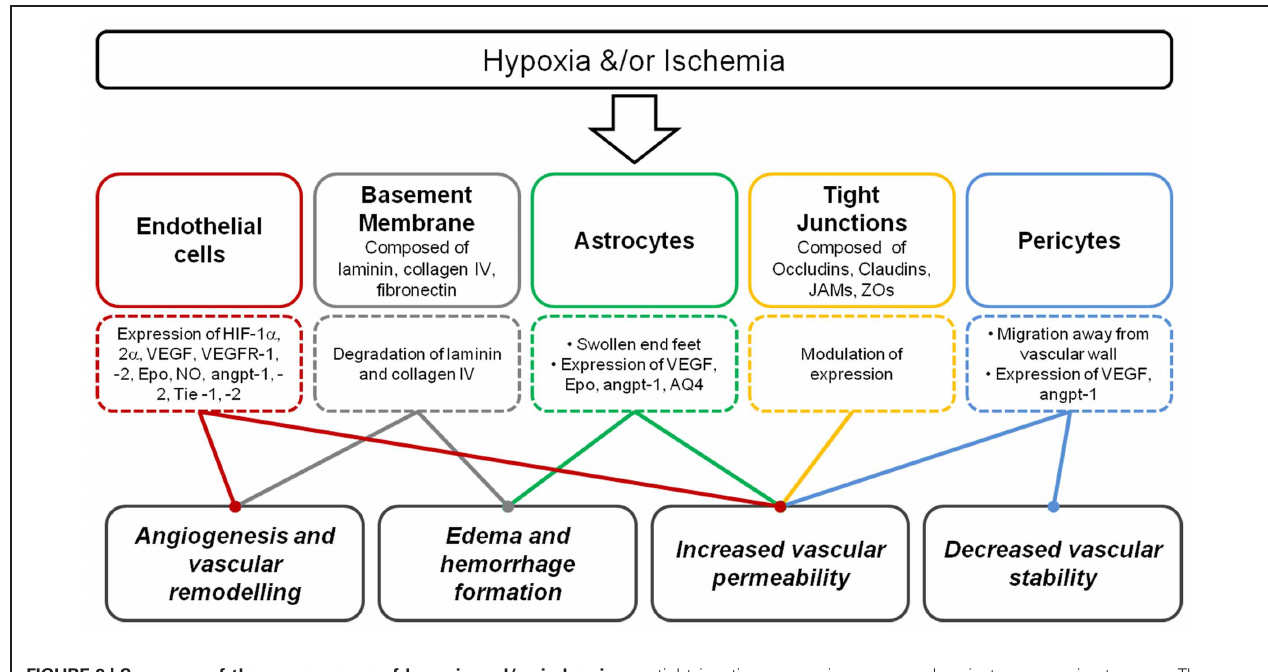
FIGURE 3 | Summary of the consequence of hypoxia and/or ischemia on the neurovascular unit. Following hypoxia, endothelial cells express a range of key hypoxic and angiogenic factors, basement membrane degradation occurs, astrocyte end-feet become swollen, modulation of